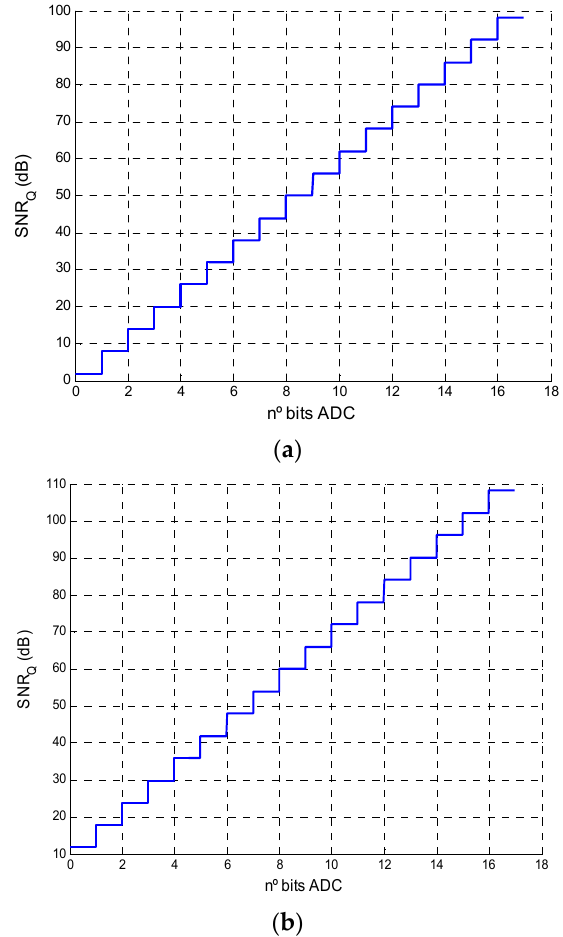
Figure 14. Quantization SNR in relation to the number of bits of the ADC, with Vpp = SPAN. ( a ) f s = 2 × BW; ( b ) f s = 20 × BW.